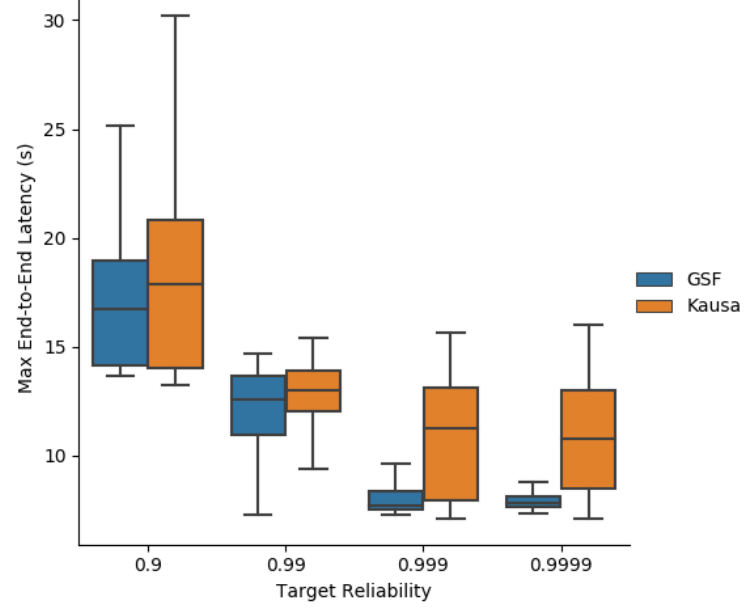
Figure 17. Maximum end-to-end latency obtained with MOpt and Kausa